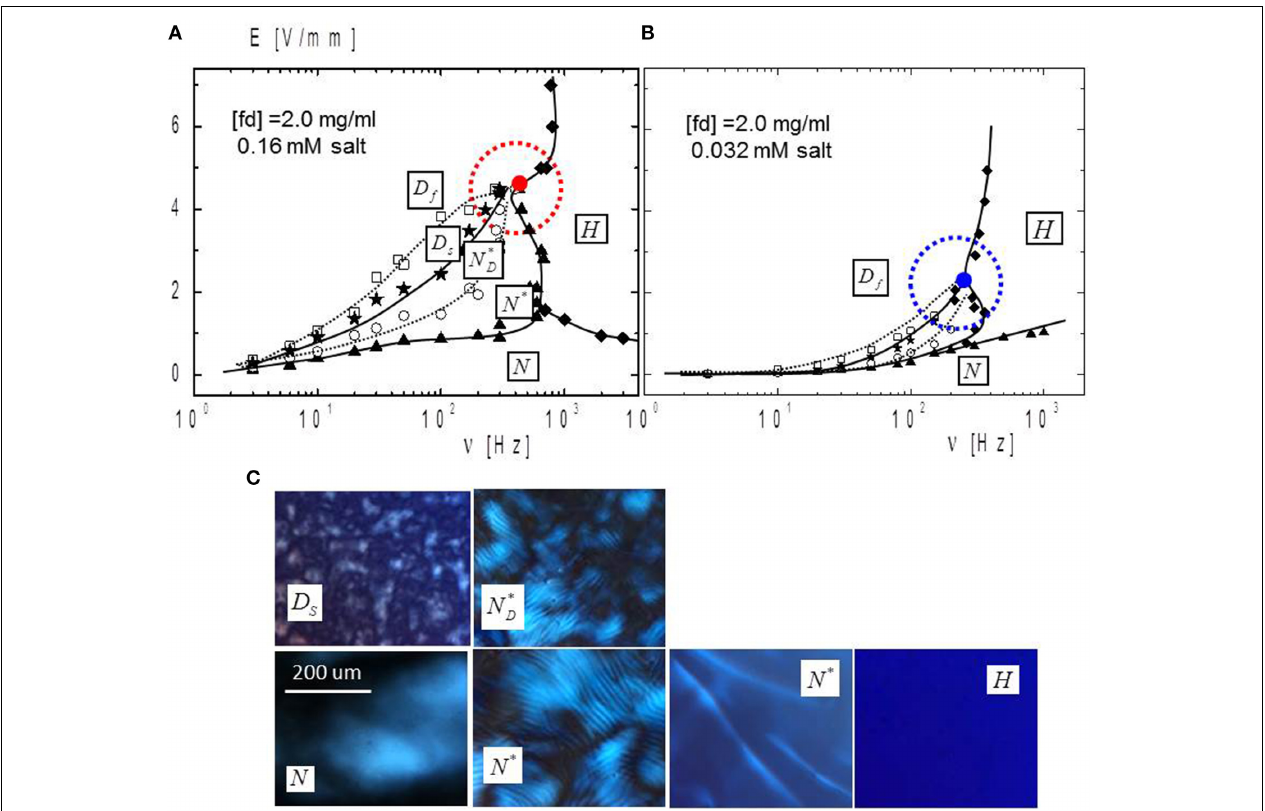
FIGURE 1 | The electric phase/state diagram in the AC field amplitude vs. frequency plane for a fd-concentration of 2.0mg/ml at (A) 0.16mM and (B) 0.032mM buffer concentration. (C) The corresponding depolarized images of the morphologies of field-induced phases/states that are indicated in the phase/state diagram. Phase transition lines are drawn to guide the eye.